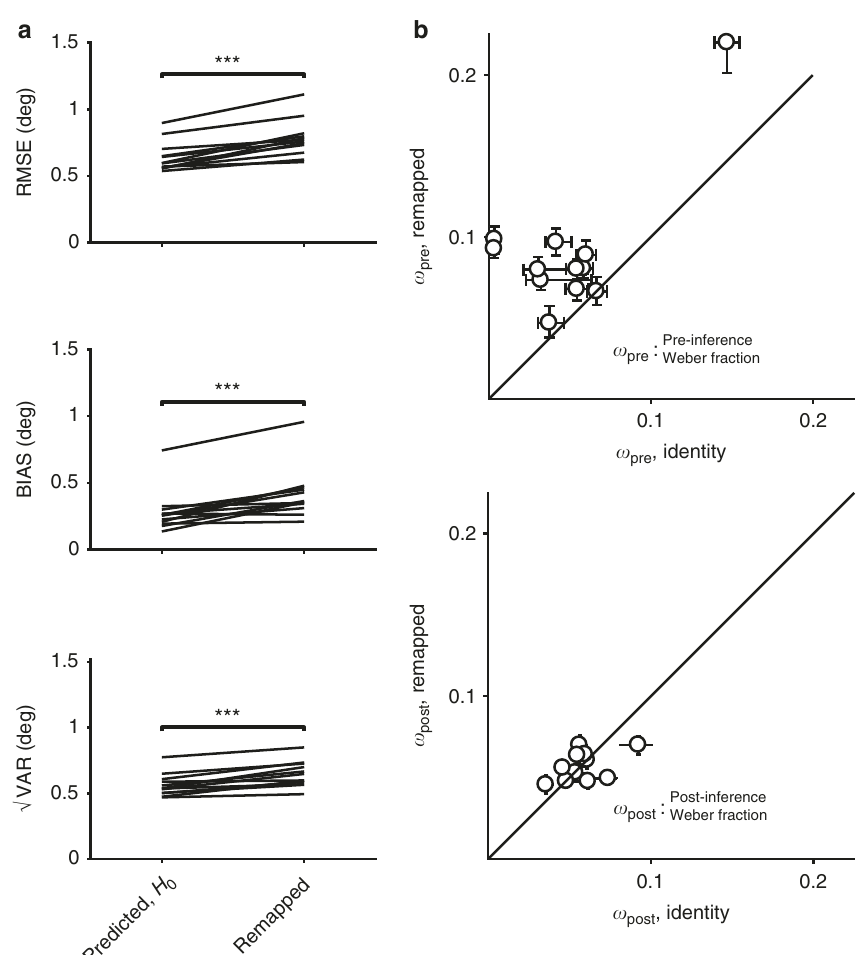
Fig. 9 Summary of subjects ’ performance in the length identi fi cation task, gain = 1.5. a Comparison of RMSE, BIAS, and √ VAR for all subjects. On the left are values from individual subjects in the identity context; on the right are the values observed from behavior in the remapped context. Similar to the sensorimotor tasks, subjects had higher error and were more biased towards the mean and more variable than was predicted assuming no MTN (***: p < 0.001, Wilcoxon two-sided signed-rank test). b . Fitting the observer-actor model independently across the two contexts resulted higher values of w fl ecting additional reliance on prior information consistent with a late inference strategy. Values for w pre in the remapped context, re signi fi cantly different between contexts. Error bars represent 95% con fi dence intervals estimated using a bootstrap procedure ( n =